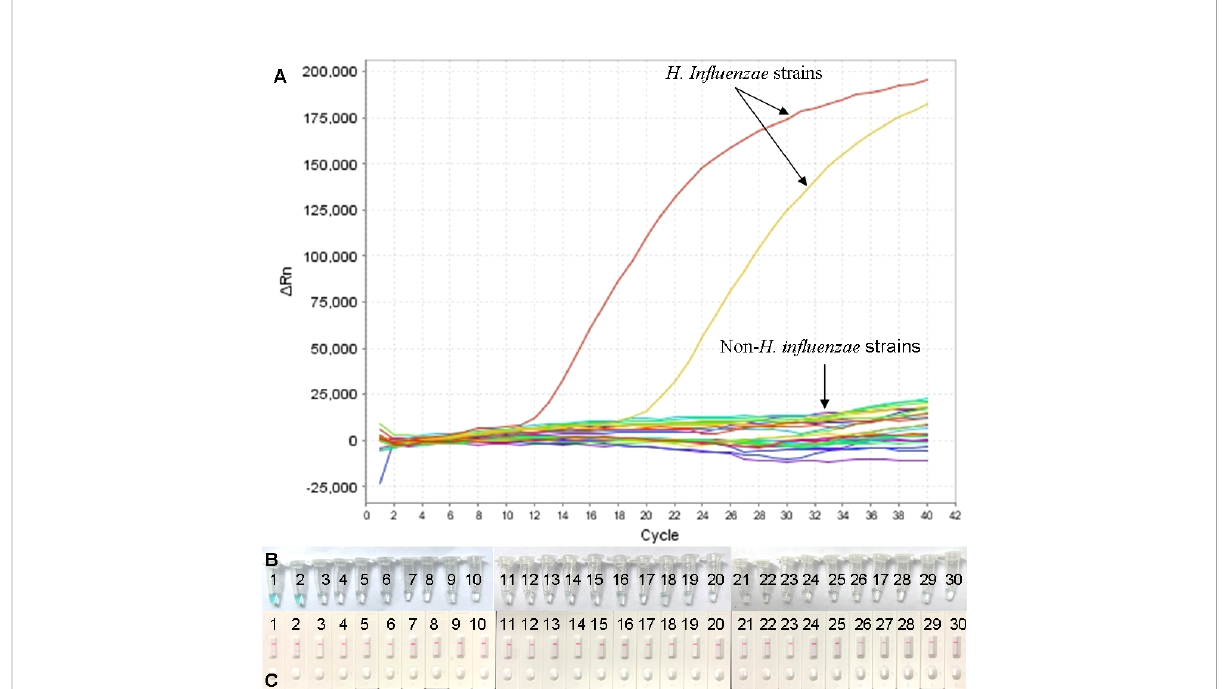
FIGURE 5 Speci fi city con fi rmation for H. in fl uenzae-real-time MCDA assay. DNA templates from 2 H. in fl uenzae strains and 28 non-H. in fl uenzae strains were tested by the real-time MCDA assay. No reactions were recorded within the non-H. in fl uenzae strains (A) . The results were also con fi rmed by MCDA reactions, indicated by visual detection reagent (B) and LFB test (C) . (B) Tube/Strips 1 and 2 represented two H. in fl uenzae strains, and the other ones represented non-H. in fl uenzae strains. (C) TL, test line; CL, control